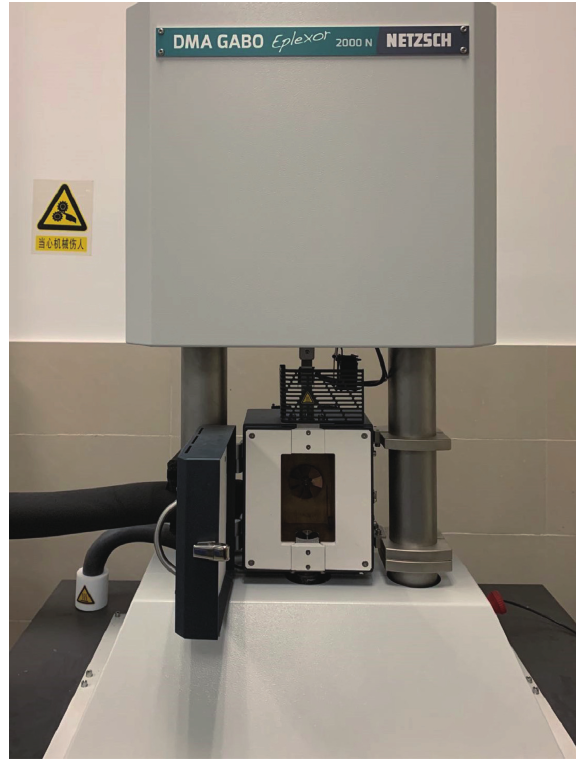
Figure 1: GABO EPLEXOR (dynamic thermophysical analyzer).